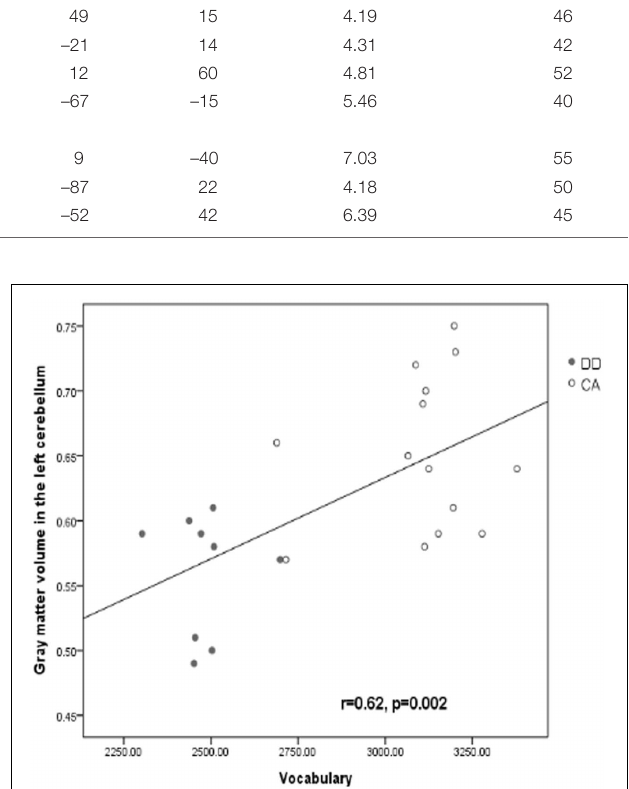
FIGURE 2 | Correlation between vocabulary score and gray matter volume in the left cerebellum. As showed in the scatter plot, the black line represents the correlation line for all